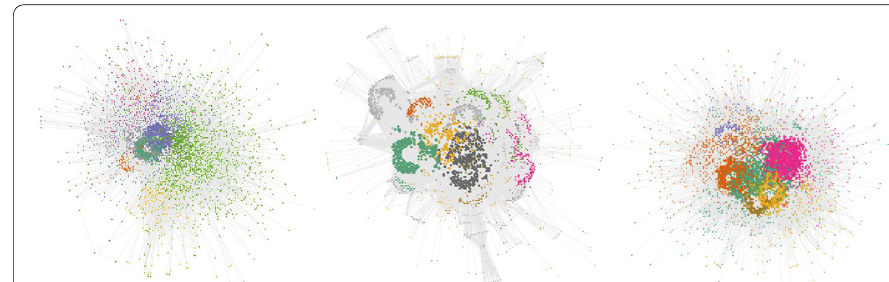
Fig. 3 Network projection and communities (left: G ′ P , middle: G ′ S , right: G ′